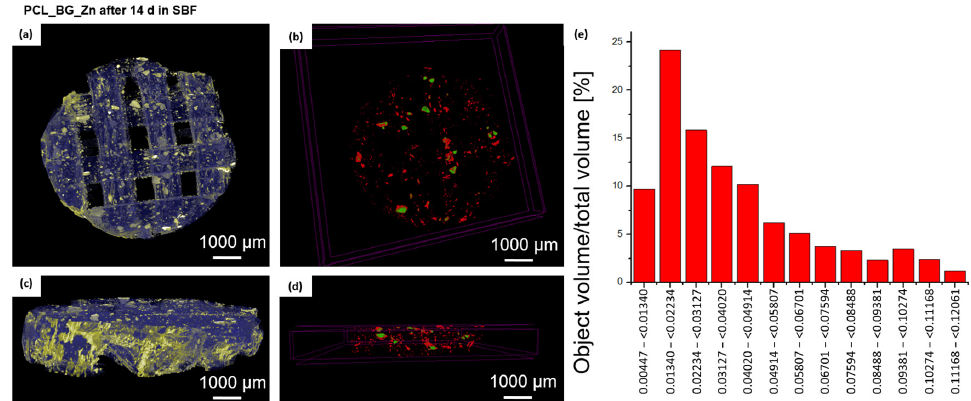
Figure 8. µ CT images of sample PCL_BG_Zn after incubation in SBF. Images showing the top view Figure 8. µCT images of sample PCL_BG_Zn after incubation in SBF. Images showing the top view ( a ) and the cross-section of the scaffold ( c ). The scaffold volume is marked in blue; the distribution ( a ) and the cross-section of the scaffold ( c ). The scaffold volume is marked in blue; the distribution of of the modifying particles is highlighted in yellow. Distribution of BG_Zn particles without the pol- the modifying particles is highlighted in yellow. Distribution of BG_Zn particles without the polymer ymer matrix ( b , d ) (particles marked in red and green). Histogram of the distribution of particles ( e ). matrix ( b , d ) (particles marked in red and green). Histogram of the distribution of particles ( e ). In the PCL_BG_Zn sample, after 14 days of incubation in SBF, 3697 incubations were Table 5. Calculation results based on µ CT detected (Figure 8), which was 0.7% of the scaffold volume. The average thickness of in- Figure 8. µCT images of sample PCL_BG_Zn after incubation in SBF. Images showing the top view clusions was 39 µm, and about 24% of inclusions were in the thickness range of 13–22 µm. ( a ) and the cross-section of the scaffold ( c ). The scaffold volume is marked in blue; the distribution of the modifying particles is highlighted in yellow. Distribution of BG_Zn particles without the pol- Table 5. Calculation results based on µCT images. ymer matrix ( b , d ) (particles marked in red and green). Histogram of the distribution of particles ( e ). In the PCL_BG_Zn sample, after 14 days of incubation in SBF, 3697 incubations were detected (Figure 8), which was 0.7% of the scaffold volume. The average thickness of in-